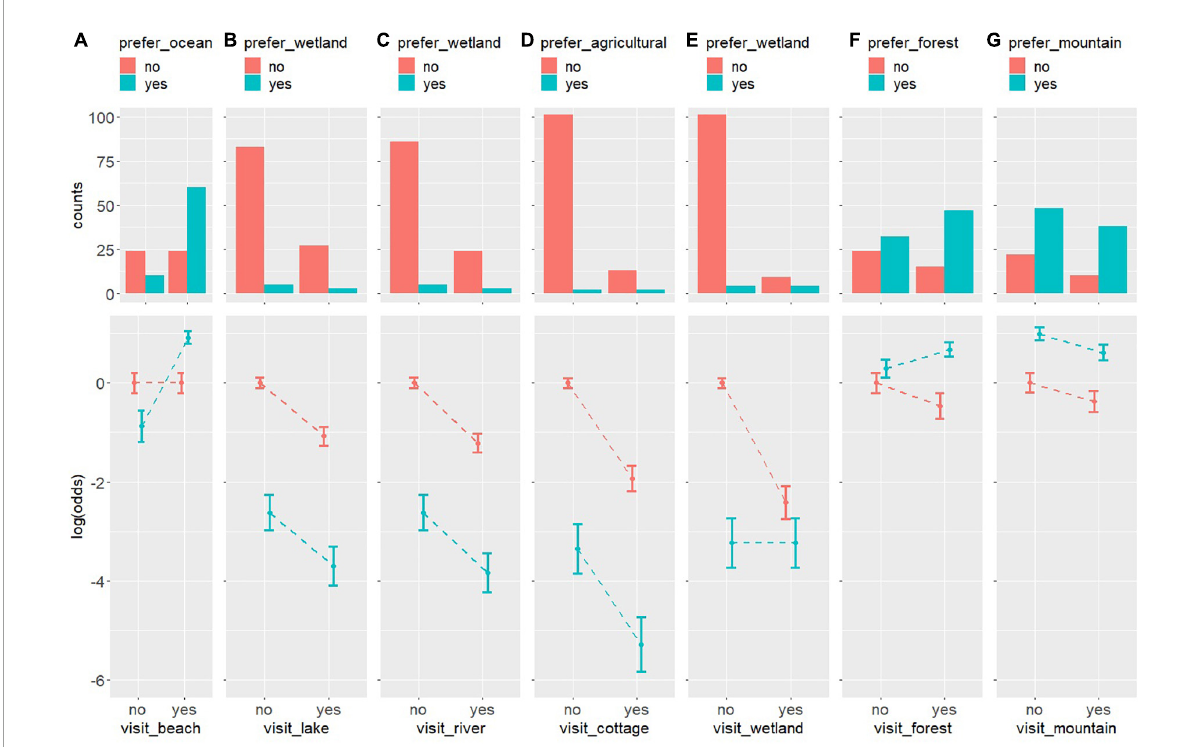
FIGURE4 Histograms and the logarithm of the odds resulting from applying a log-linear model in the cross-frequency tables of the relationships between landscape type preference and green location type usually visited by PwMD, from left to right, ocean vs. beach (A) , wetland vs. lake (B) , wetland vs. river (C) , agricultural vs. cottage (D) , wetland vs. wetland (E) , forest vs. forest (F) , mountain vs. mountain (G)